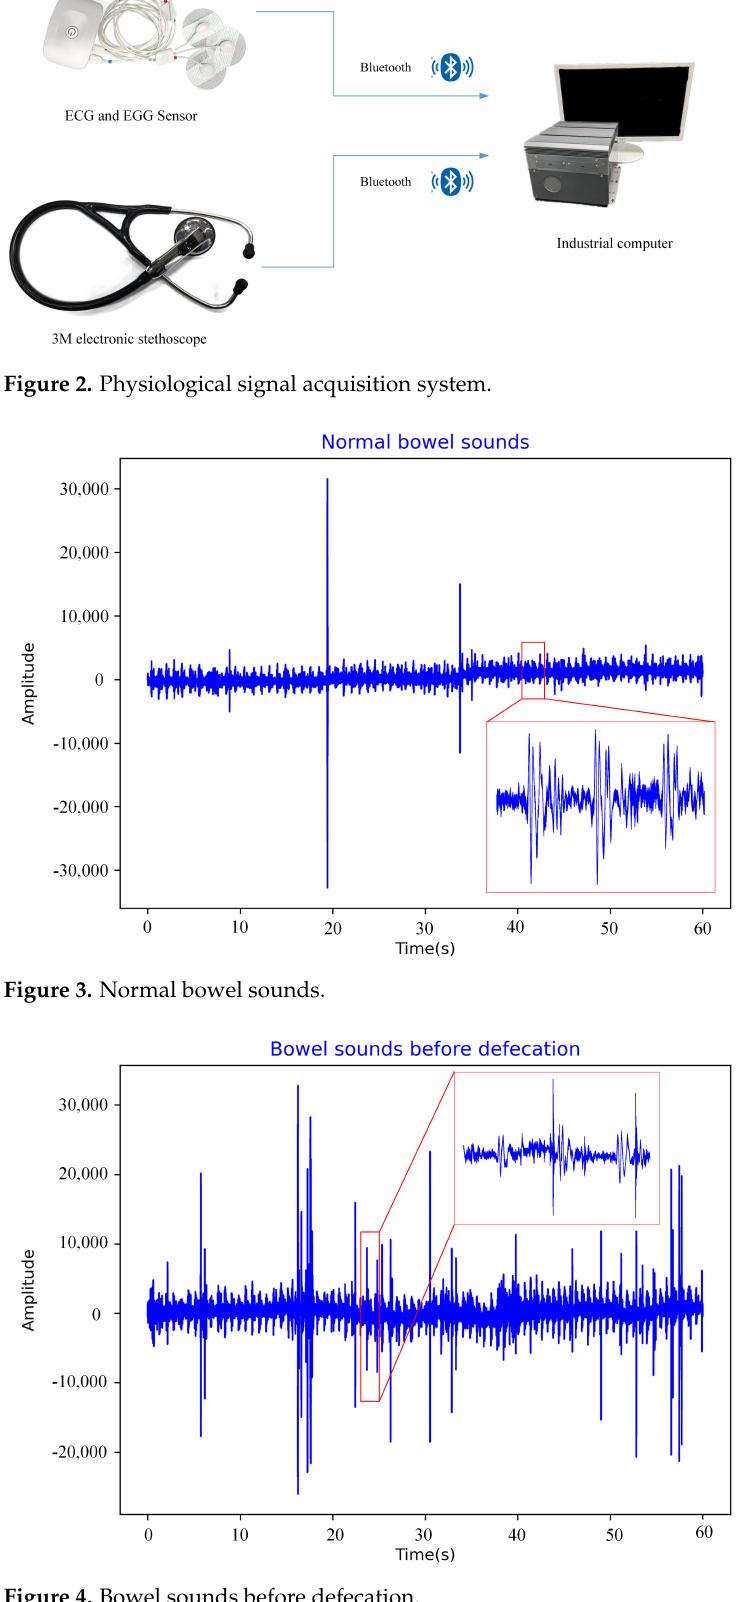
Figure 4. Bowel sounds before